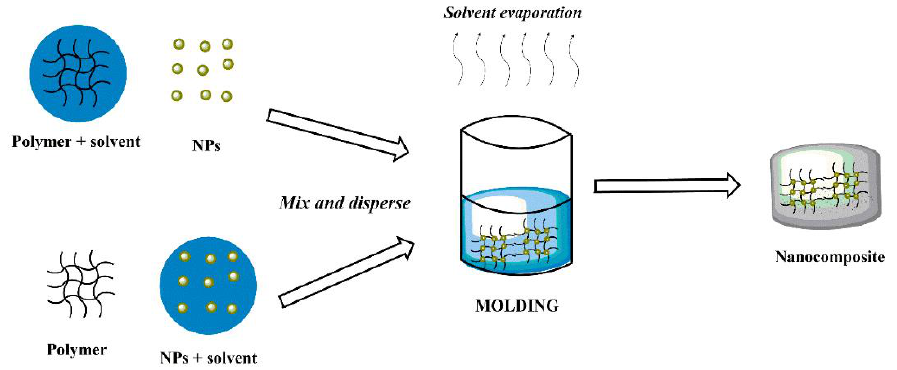
Figure 3. Schematic representation of molding method. Reprinted with permission from ref. [57], MDPI, 2022.